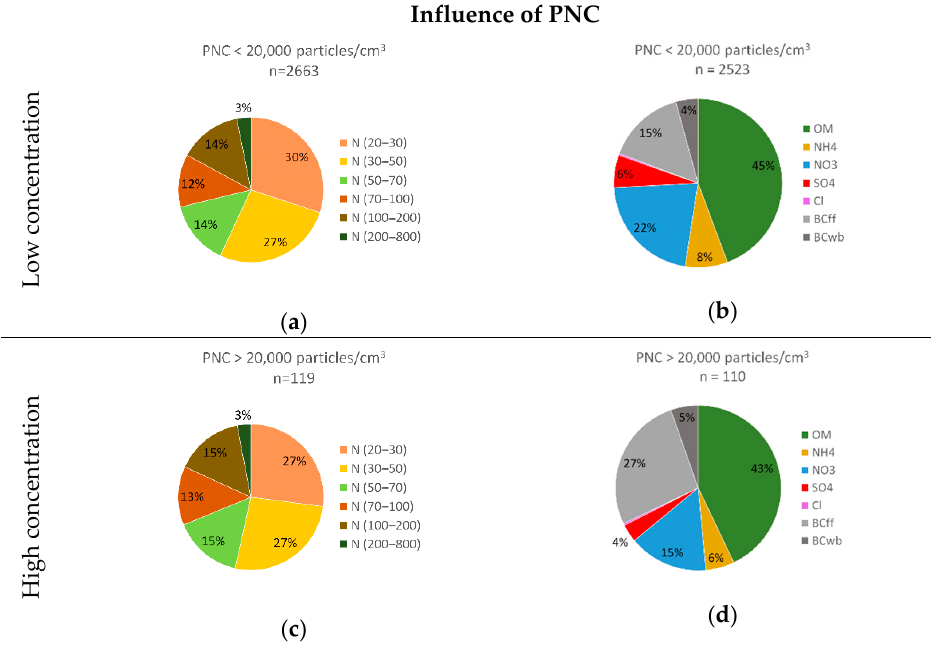
Figure A5. Particle size contribution ( a ) and chemical composition ( b ) for low PNC and particle size contribution ( c ) and chemical composition ( d ) for high PNC at the roadside site.